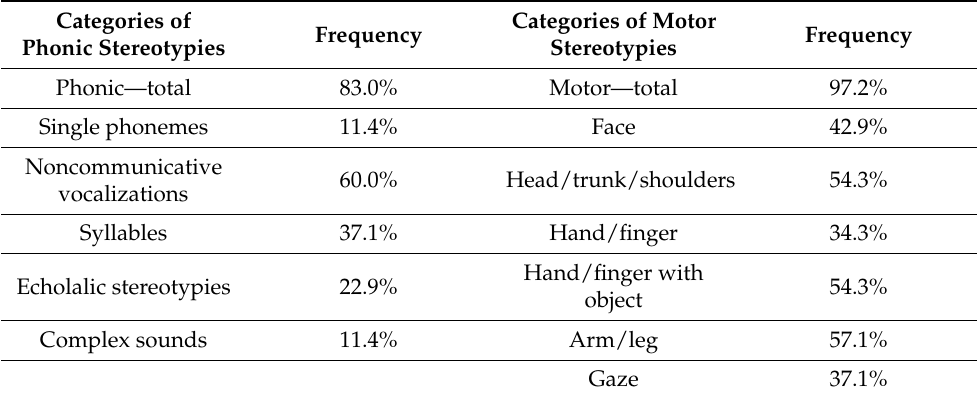
Table 2. Frequency and types of phonic and motor